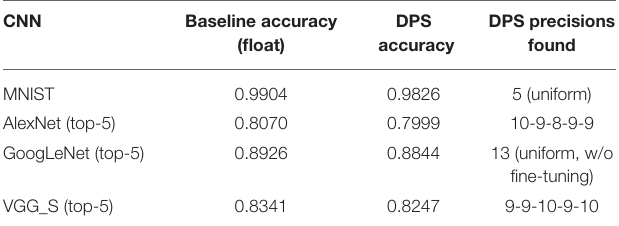
FIGURE 9 | Comparison with the digital baseline and Stripe. (A) Area (mm 2 ), (B) # MAC of a tile (1k), (C) Average cycles, (D) Normalized ADP, (E) Power (mW), and (F) Normalized energy. TABLE 1 | Recognition accuracy (for 10K images) and dynamic precision scaling (DPS) precision